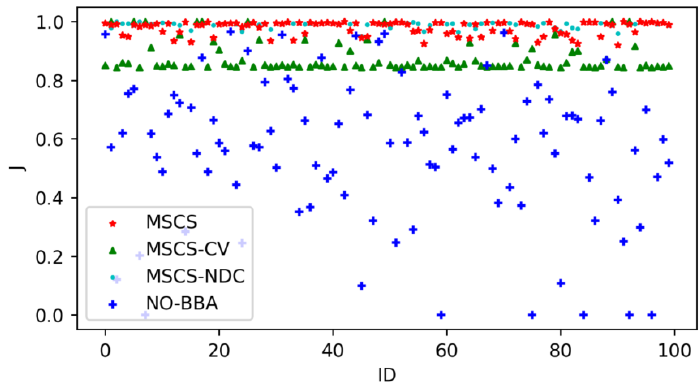
Figure 10. A comparison of the remaining energy of the node of the proposed method with NO-BBA, JGC-MSCS-CV, and JGC-MSCS-NDC methods for WRSN.